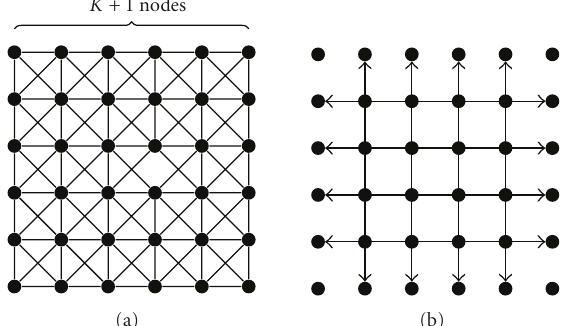
(cid:2)√ d (cid:4) , with d = 2 depicted here, is achievable. Nodes are located at integer coordinates √ d , as depicted in (a). Unicast sessions are placed according to (b).